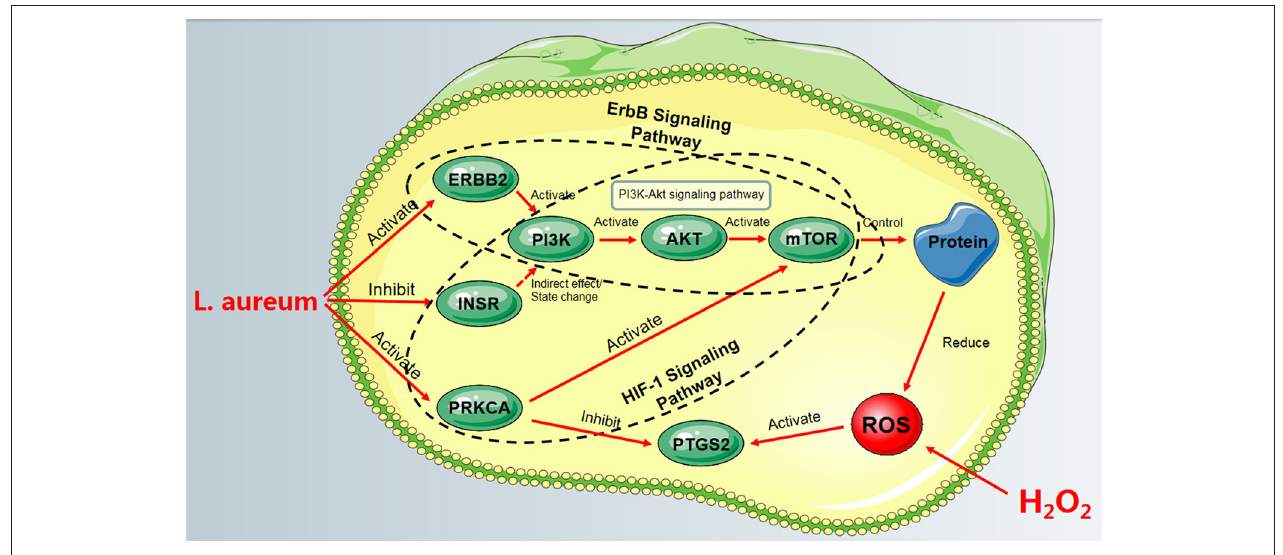
FIGURE 10 | The process of L. aureum mitigating oxidative stress of cells.